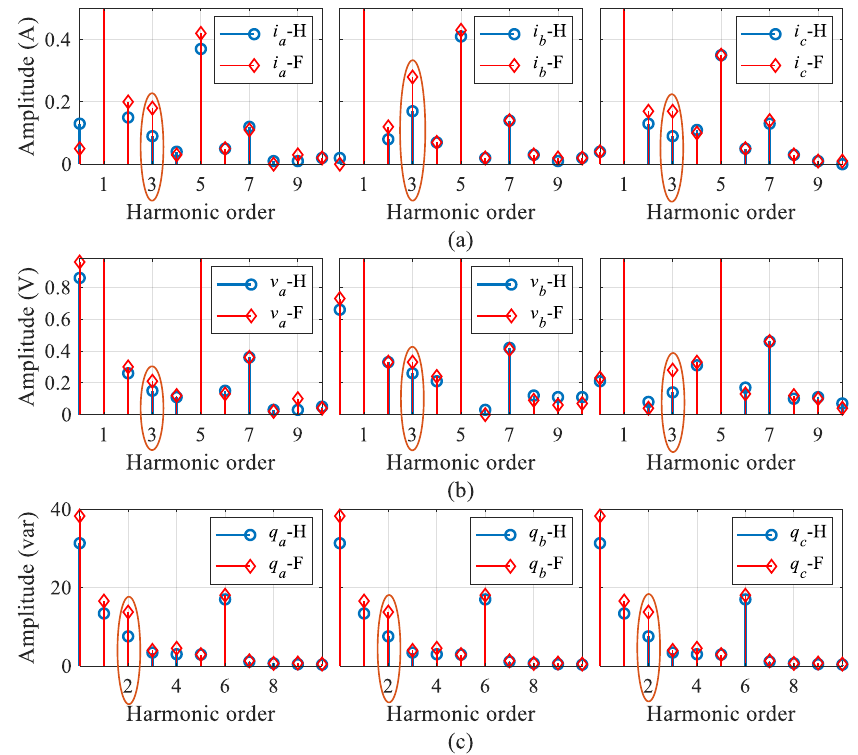
Figure 11. The spectra of currents ( a ), voltages ( b ) and phase IRPs ( c ) in healthy and faulty cases. The same operating conditions and fault severity as Figure 10.